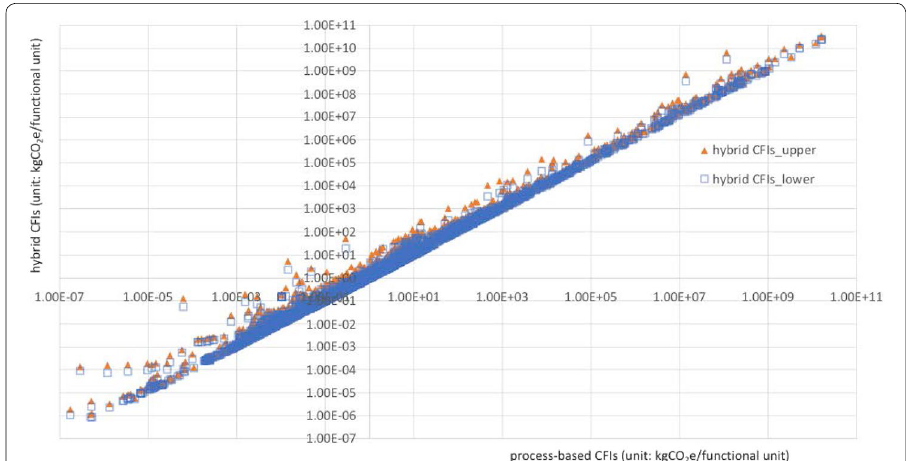
Fig. 8 Hybrid (upper- and lower-bound DCC) versus process-based carbon footprint intensities of 4325 AusLCI